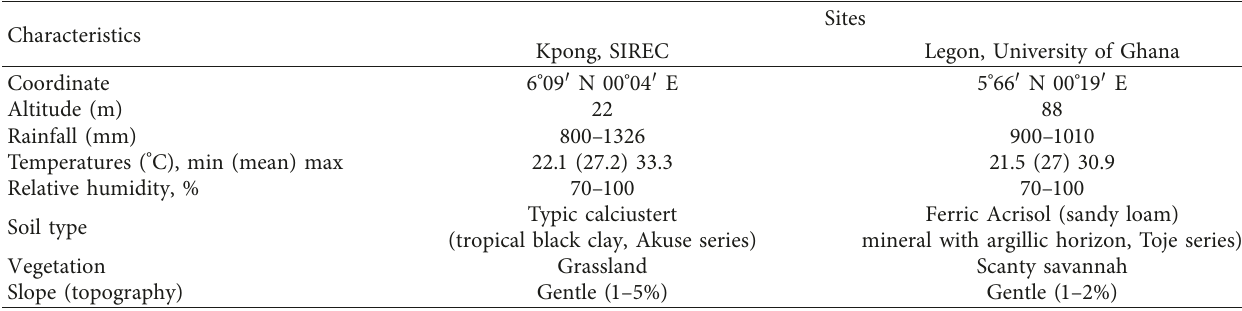
Table 1: Main characteristics of the experimental